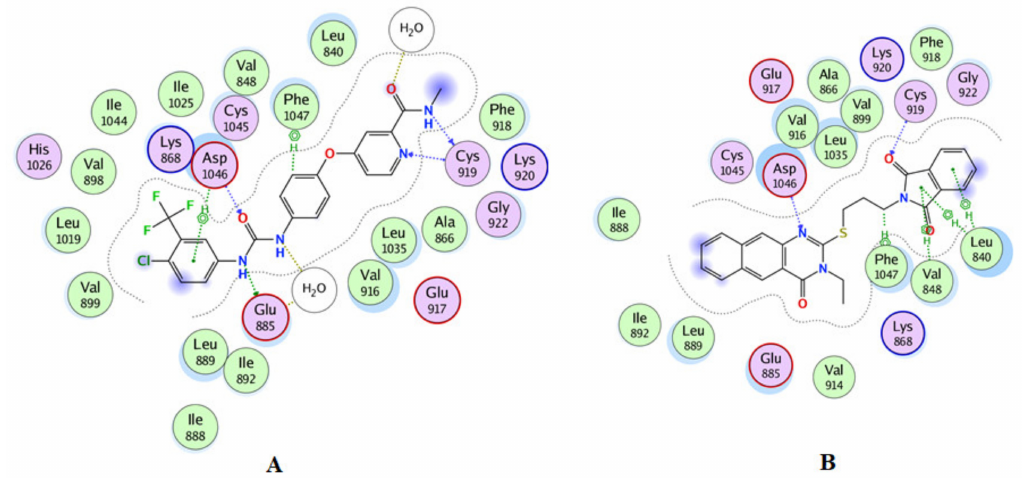
Figure 8. ( A ) 2D interactions of the co-crystallized ligand inside the active site of 4ASE (sorafenib); ( B ) 2D interaction of compound 15 in the active site of VEGFR-2.